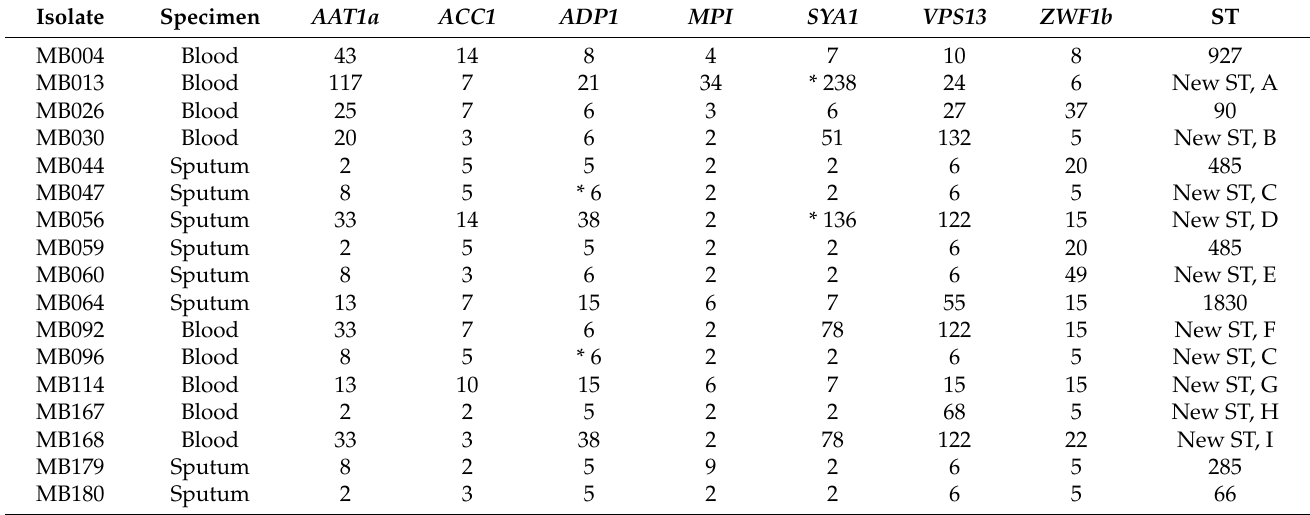
Table 3. Results of multilocus sequence typing (MLST) of Candida albicans